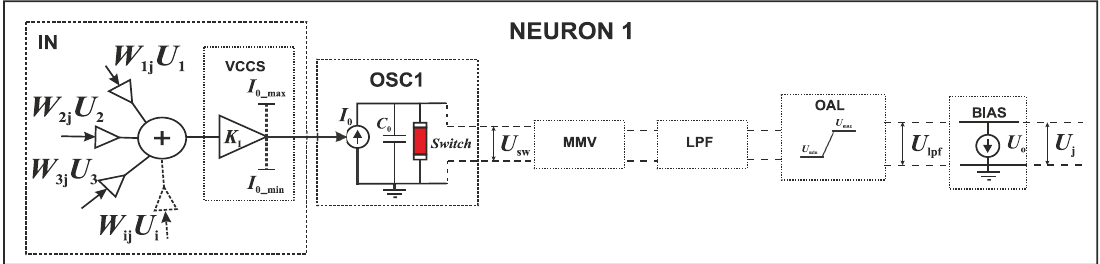
Figure 6. LIF scheme of a neuron (Neuron 1) based on